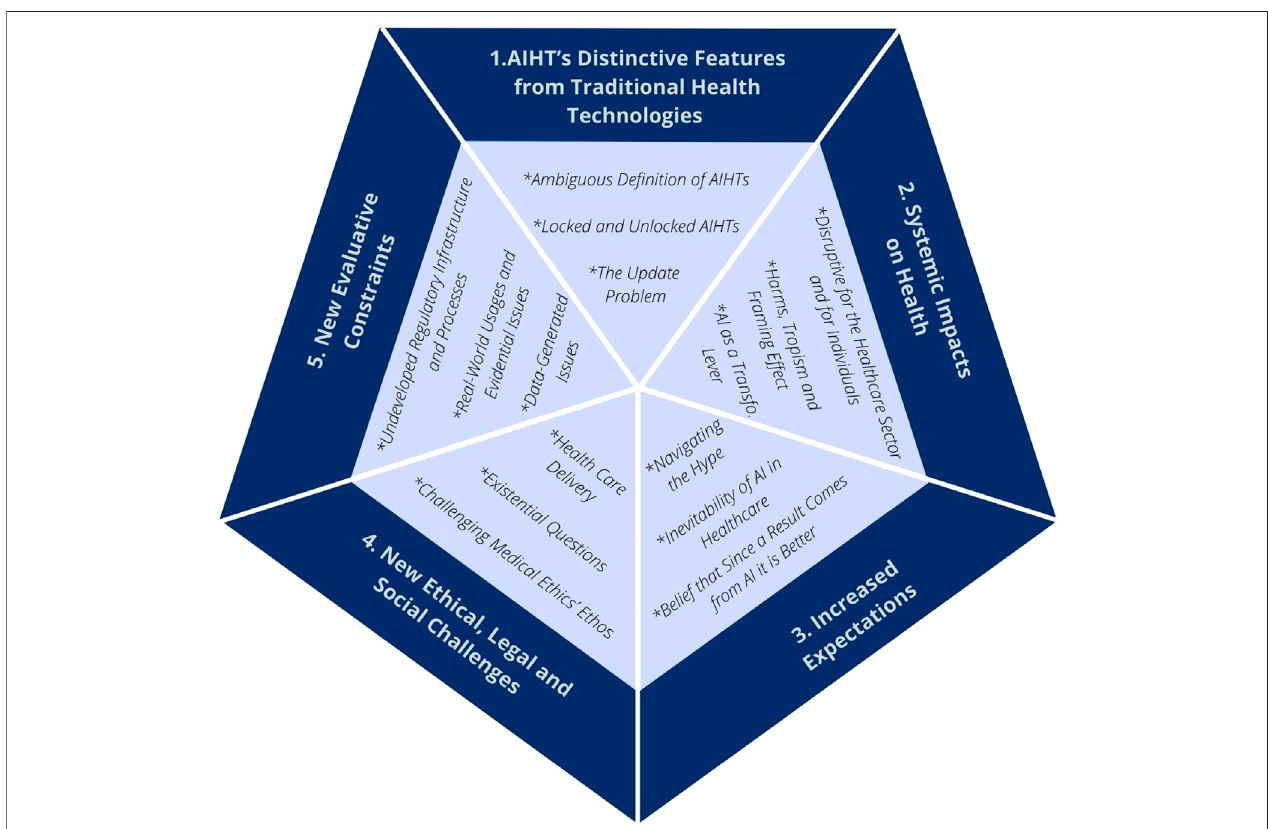
FIGURE 2 | The fi ve main aspects of arti fi cial intelligence health technologies ’